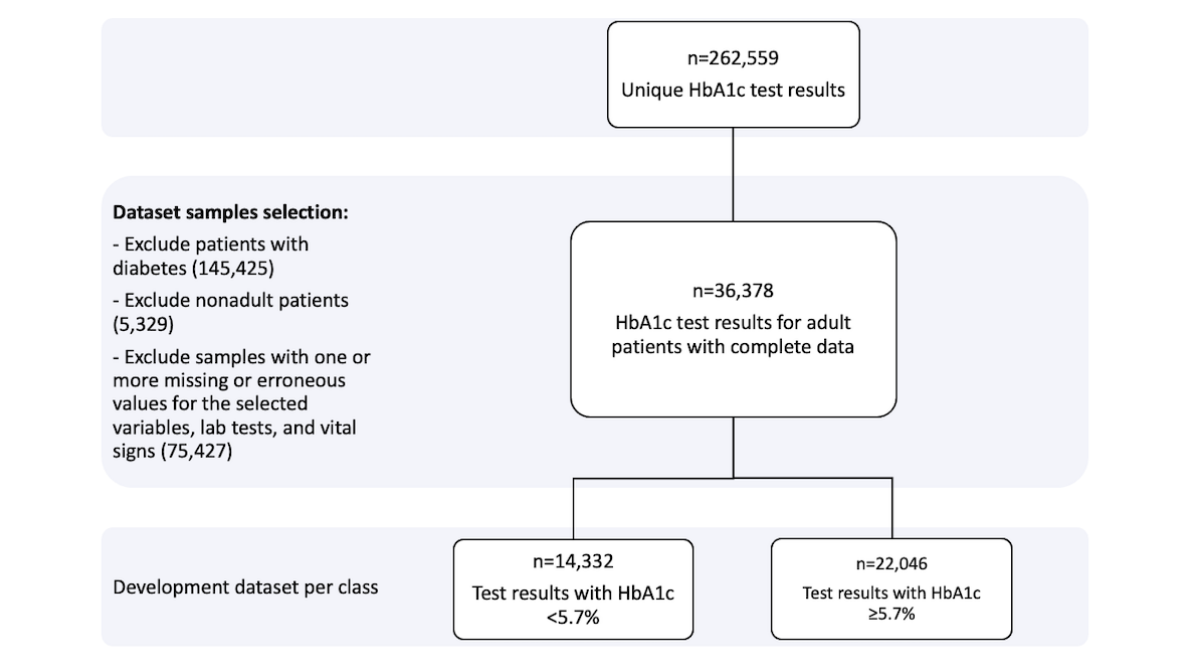
Figure 1. Dataset preprocessing details. HbA 1c : glycated hemoglobin.